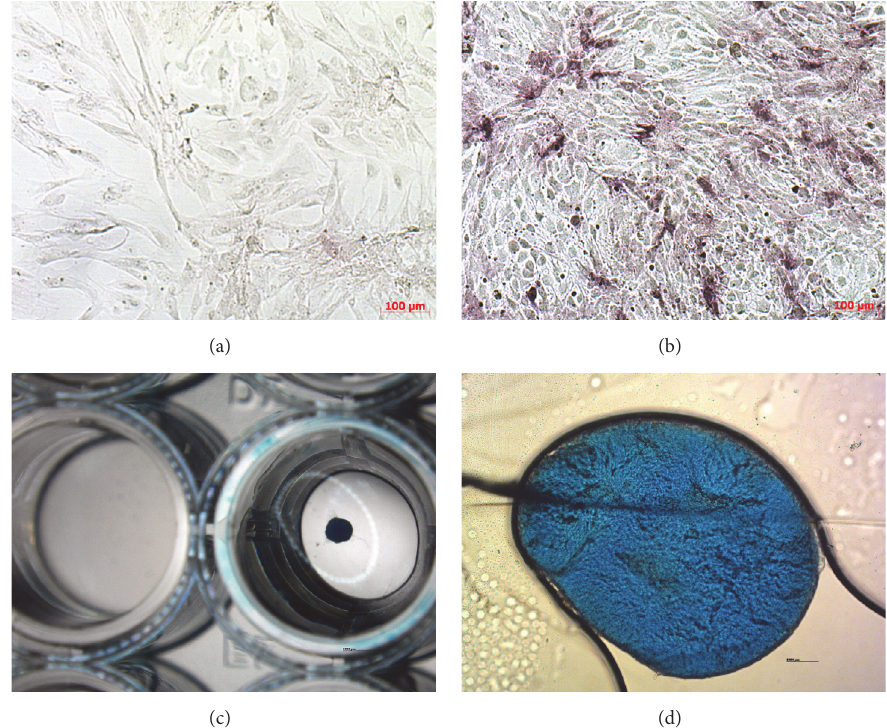
Figure 1: Differentiation of canine adipose derived stem cells. (a) Canine adipose derived stem cells negative for alkaline phosphatase activity (negative control for osteoblasts differentiation). (b) Osteoblast differentiation. Canine adipose derived stem cells stained for alkaline phosphatase activity with NBT substrate (purple). (c) Chondrodifferentiation of canine adipose derived stem cells in microwell plate stained with Alcian Staining Solution, negative and positive well. Positive well contains blue spheroid. (d) Chondrodifferentiation of canine adipose derived stem cells. Spheroid stained with Alcian Staining Solution.